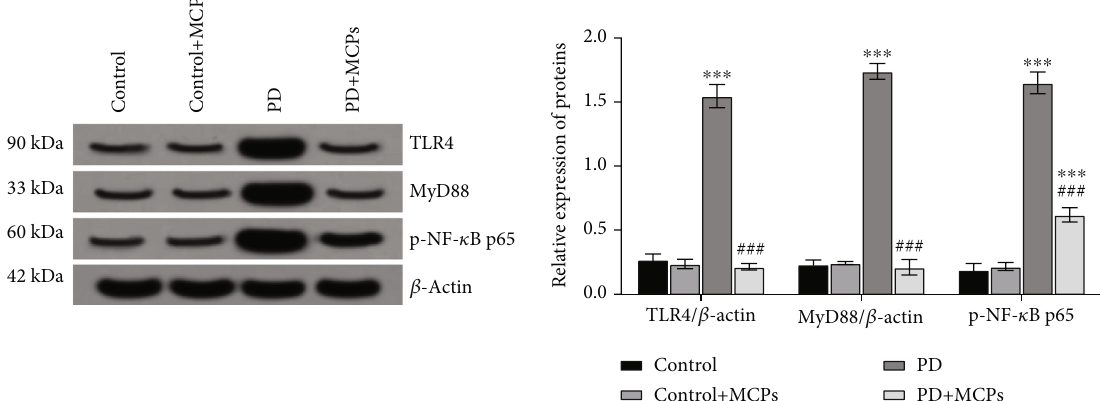
Figure 6: MCPs regulate the activation state of TLR4/MyD88/NF- κ B signaling pathway. The expression level of TLR4, MyD88, p-NF- κ B p65 protein in the striatum tissue homogenate. Compared with the Control group (Control+MCPs group), ∗∗∗ P < 0 : 001 , and compared with the PD group, ### P < 0 : 001